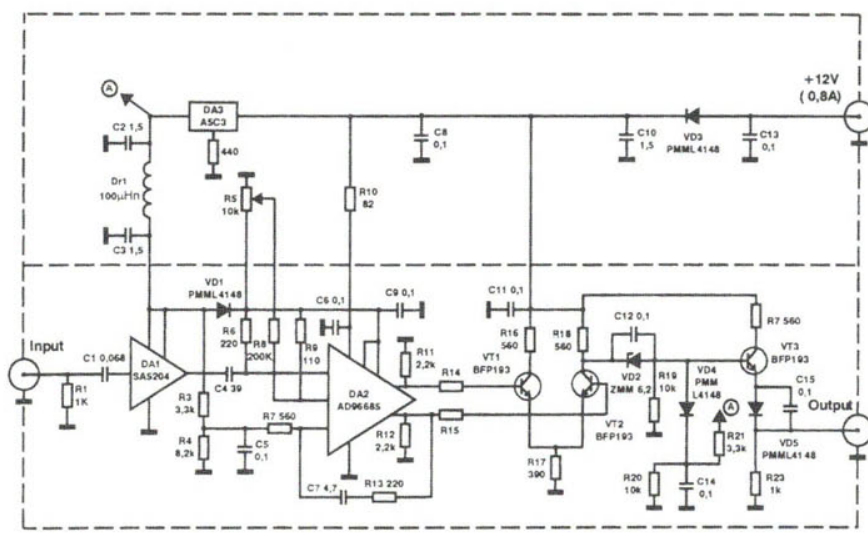
Fig. 4. A circuit-diagram of the F316